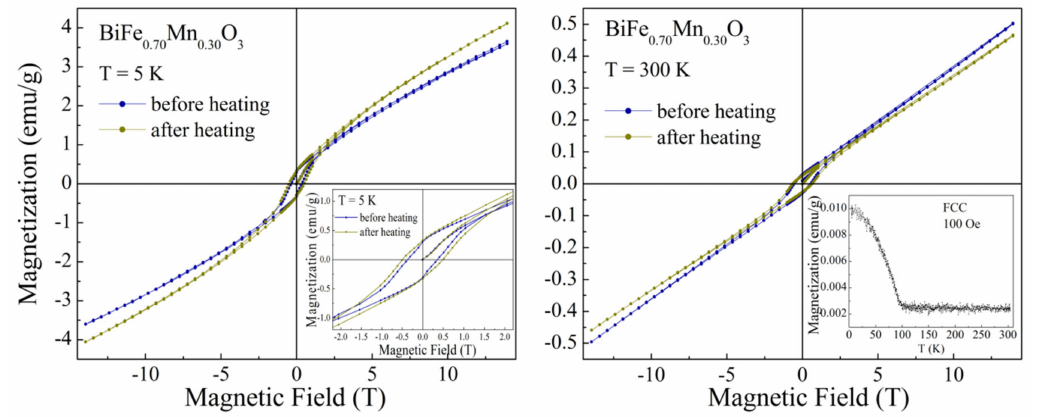
Figure 3. Isothermal magnetization dependencies recorded at temperatures of 5 K ( left ) and 300 K ( right ) before and after annealing at 700 K. The inset shows the FCC curve obtained in a field of 100